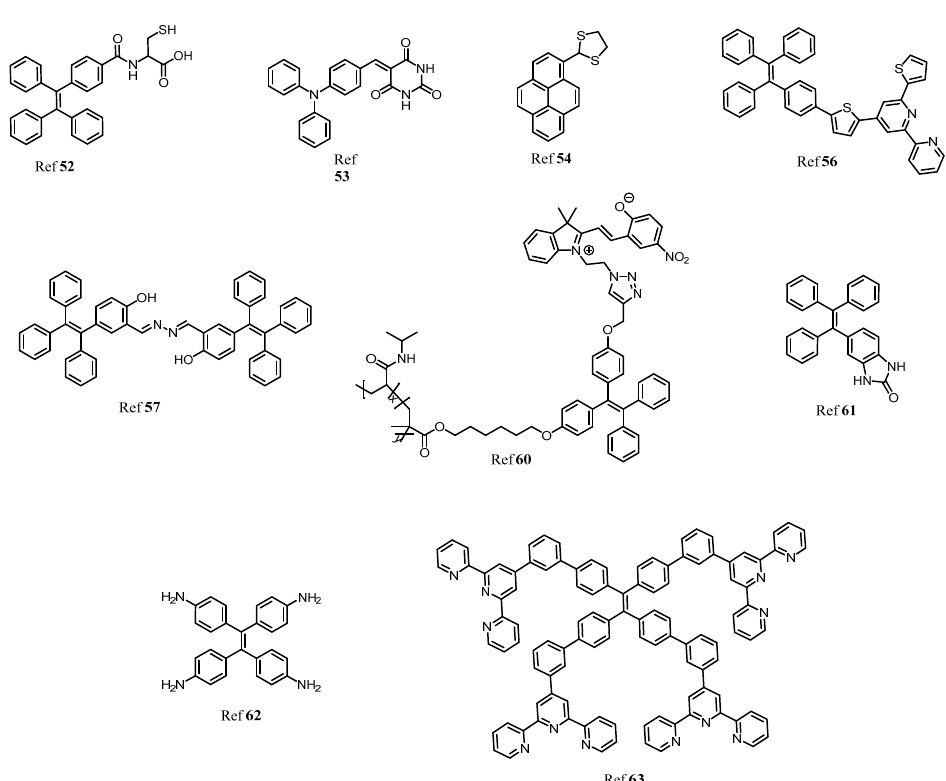
Figure 8. The structural representation and examples of several substituted AIE active fluorescent materials for sensing non-essential metal ions and anions.